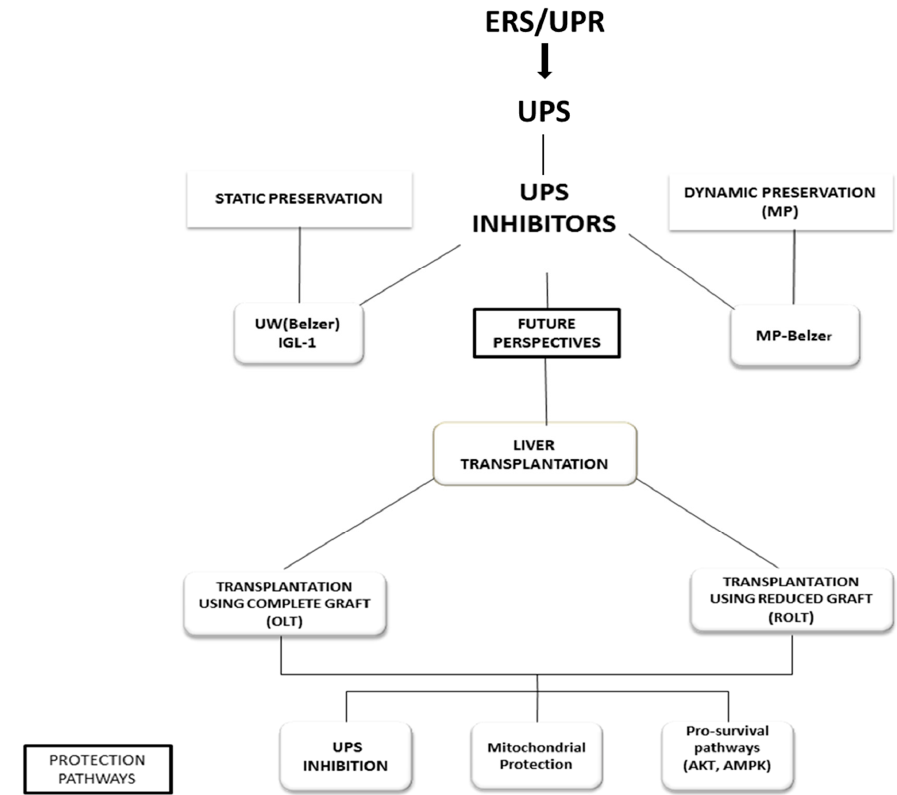
Figure 1. New perspectives to use ubiquitin-proteasome system (UPS) inhibitors as additives in static (University Wisconsin (UW) and Institut Georges Lopez-1 (IGL-1) solutions) and dynamic machine perfusion (MP) (MP Belzer solution) liver preservation; as well as in liver transplantation using